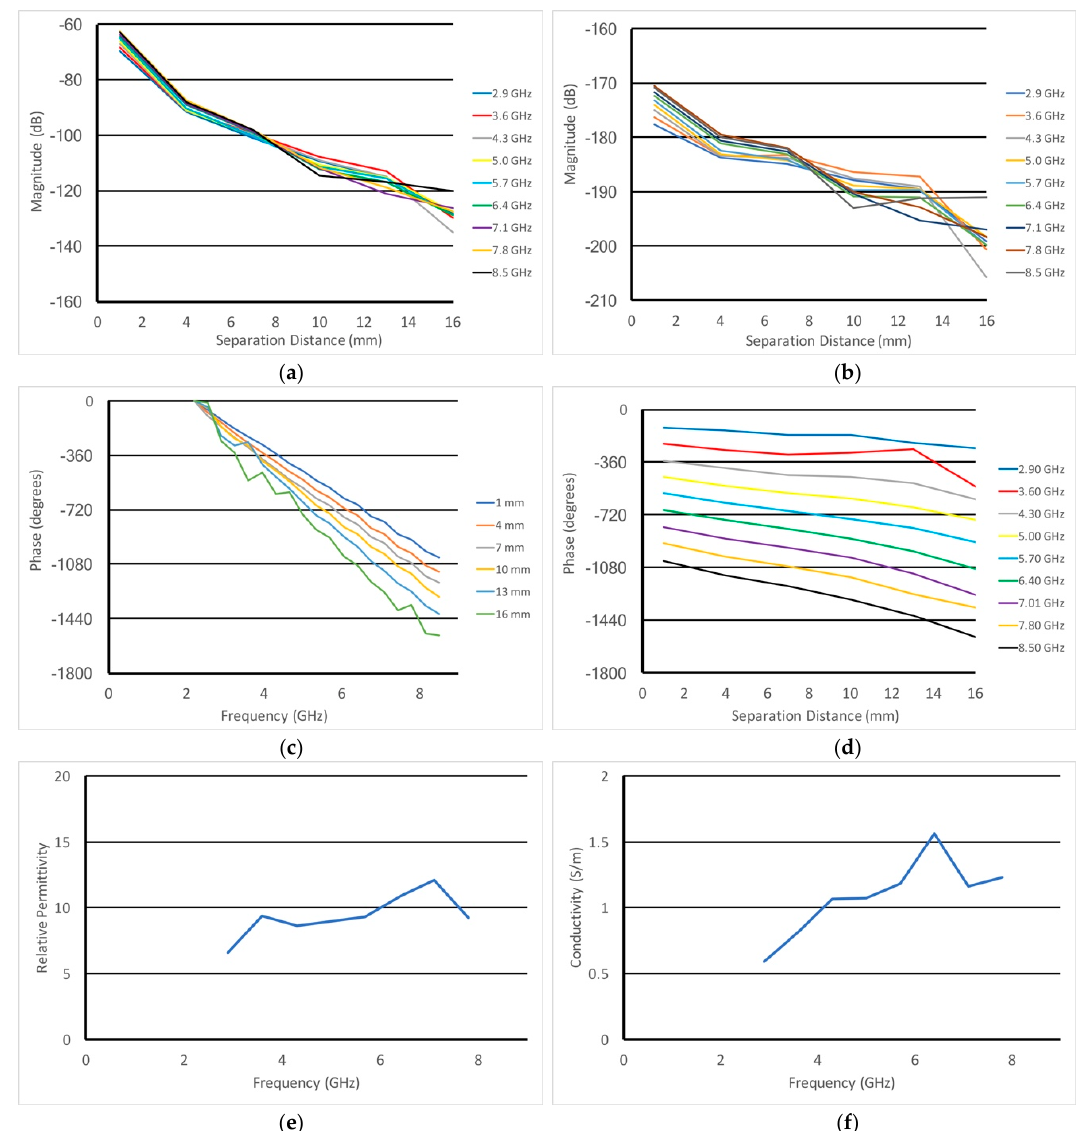
Figure 7. Plots of the ( a ) magnitude as a function of separation distance and ( b ) with the 1/ r 2 term subtracted out for a set of representative frequencies, respectively. Plots of the ( c ) unwrapped phases as a function of frequency and ( d ) the phases as a function of separation distance. Plots of the recovered ( e ) permittivity and ( f ) conductivity as a function of frequency utilizing the transmission mode technique.